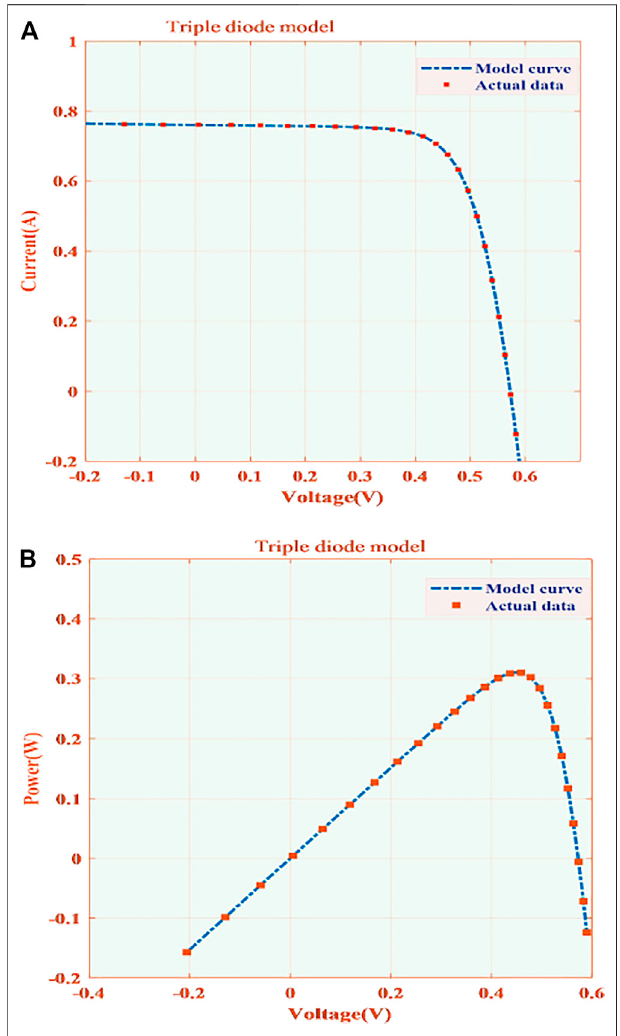
FIGURE 3 | Comparison between actual data and the model curve obtained by the MA for the TDM (A) I-V curve and (B) P-V